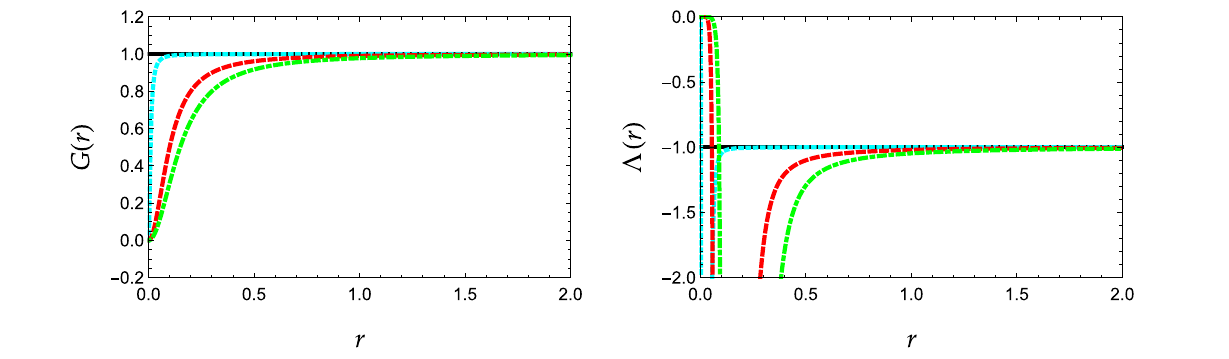
Fig. 1 Left panel: Gravitational Newton’s coupling from a given parametrization in asymptotically safe gravity. Right panel: Cosmo- logical coupling Λ( r ) for a given G ( r ) . In all four figures we fix